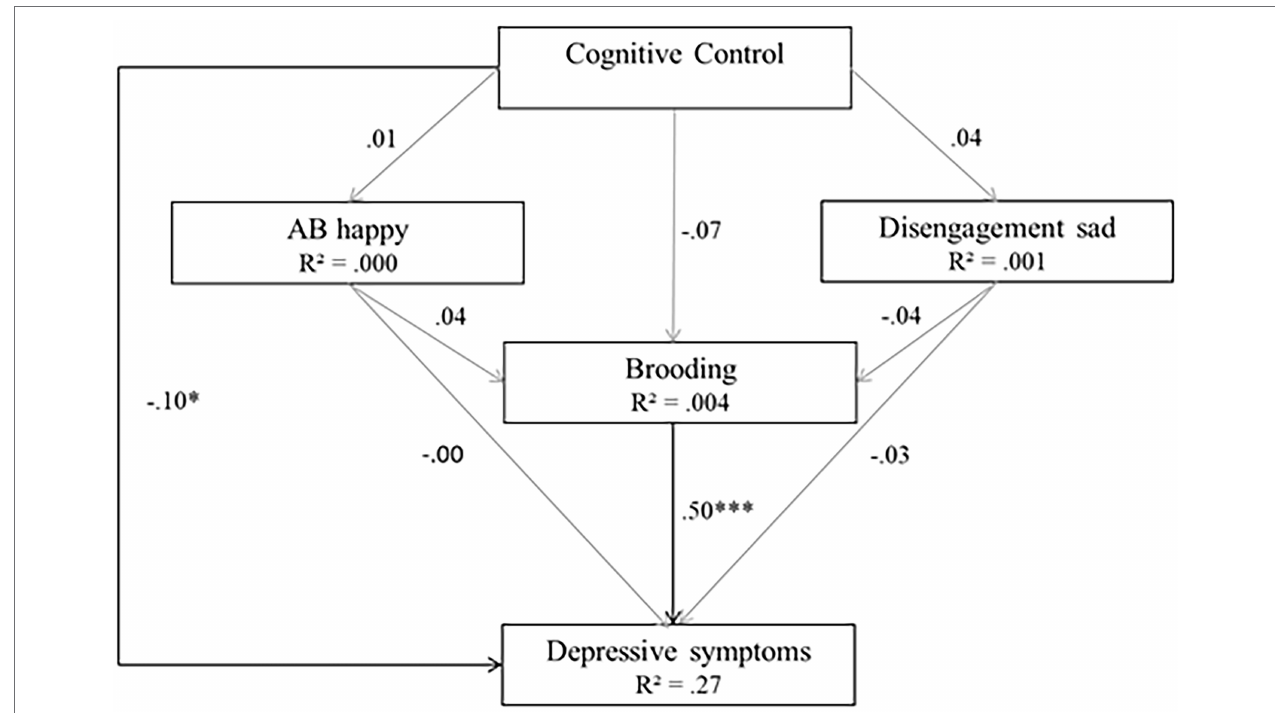
FIGURE 5 | Model 3 (cognitive model). Initial structural equation model. Rectangles represent observed measured variables. Values are path-standardized coefficients. R 2 represents the proportion of the variance for a dependent variable that is explained by an independent variable or variables in a regression model. *** indicates a significant path coefficient at p < 0.01. * indicates a significant path-coefficient at p < 0.05. (black: p < 0.05; gray: p > 0.05).